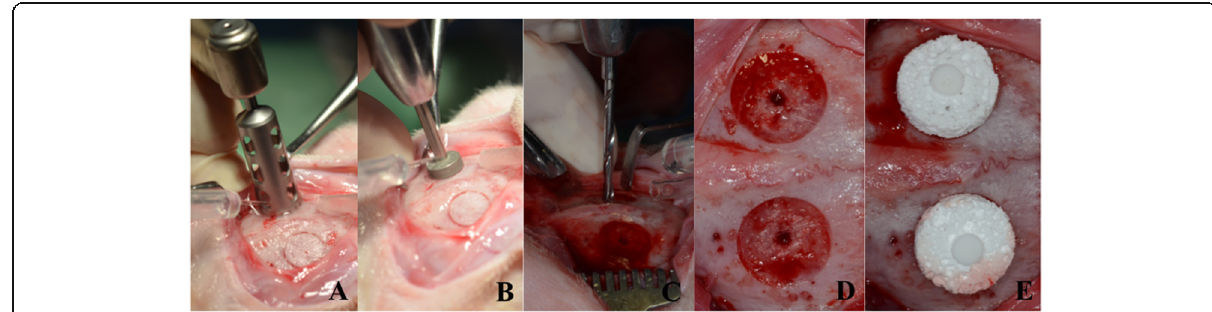
Fig. 2 Surgical procedure. Creation of the recipient bed. The calvarial bone is marked by an 8-mm trephine bur ( a ). The cortical bone is cleared using burs ( b ). The area is rinsed with saline to remove bone debris and the center of the recipient bed is perforated with a 1.3 mm drill bit ( c ). The recipient beds are finished preparation ( d ).The blocks are positioned and fixed with fixation pins at each of the prepared sites ( e